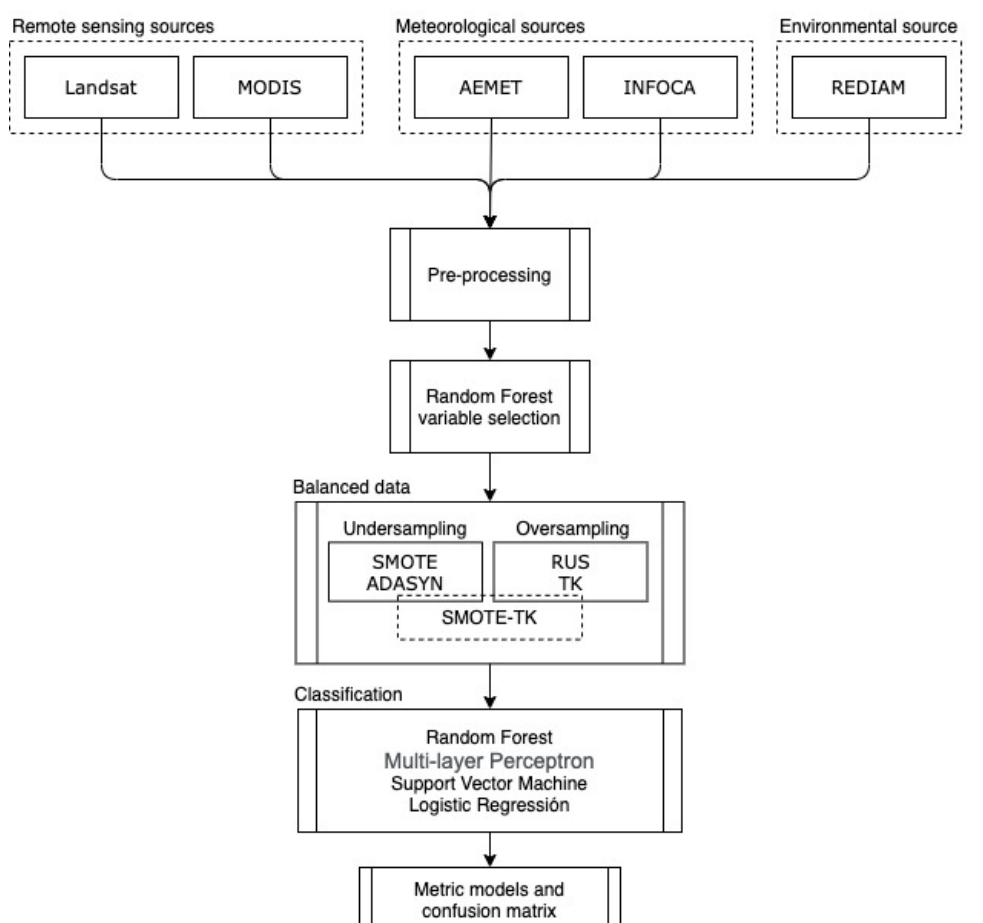
Figure 2. Flowchart used for predicting large fires.